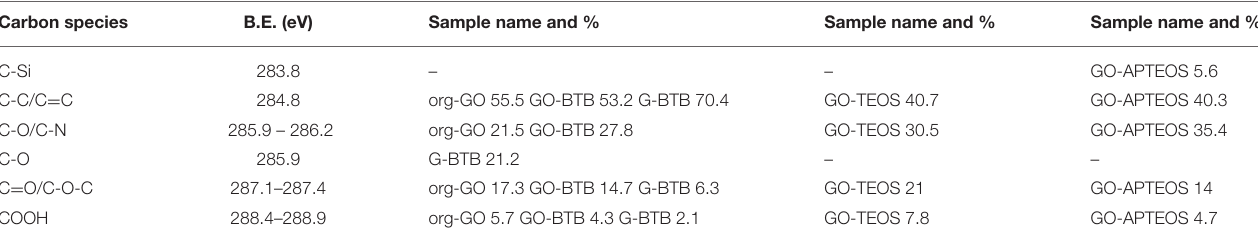
TABLE 1 | Binding energies and percentages indicating how much the component contributes to the total C1 s intensity; these percentages indicate the relative amounts of carbon atoms involved in each type of bond as deduced from the XPS measurements. Carbon